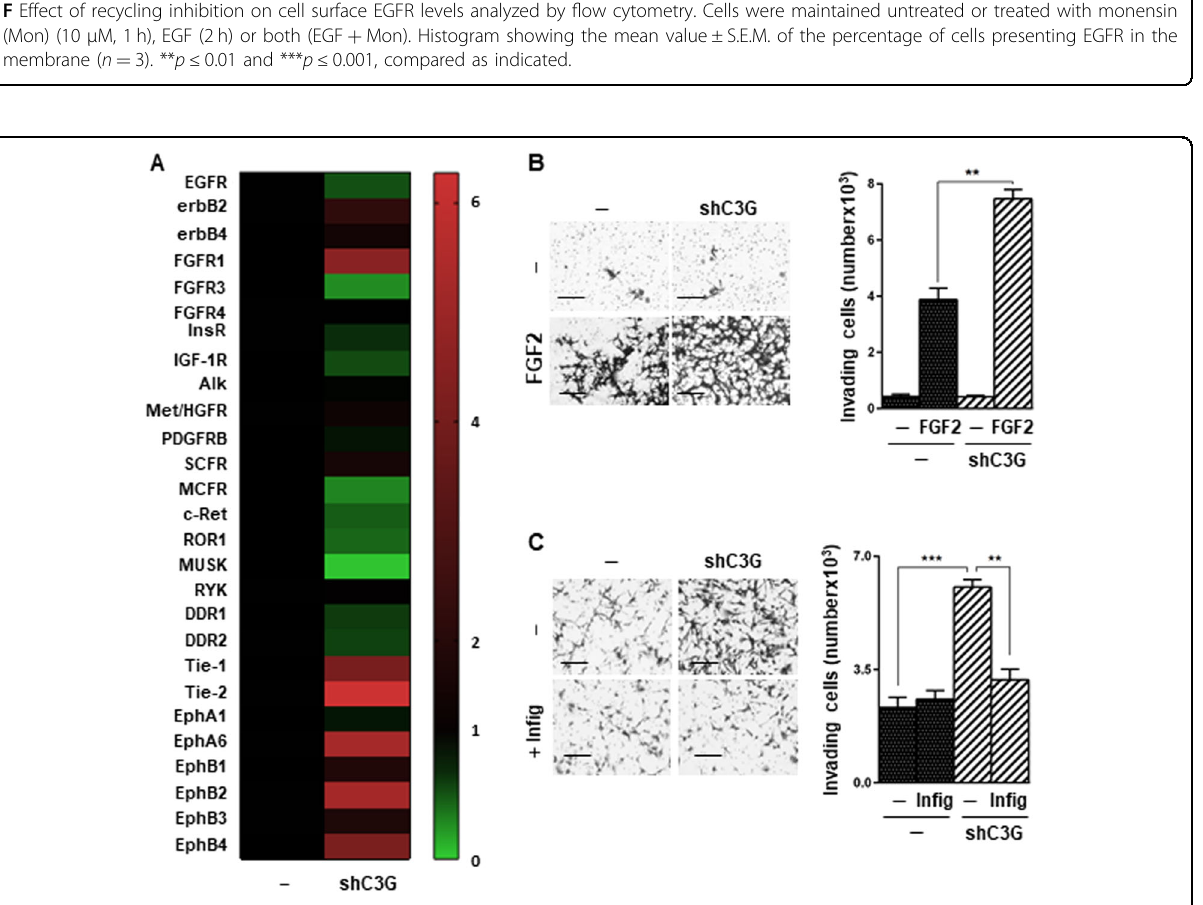
the defective EGF/EGFR signaling, such as the reduced formation of EGFR-Crk-C3G complexes 28 .